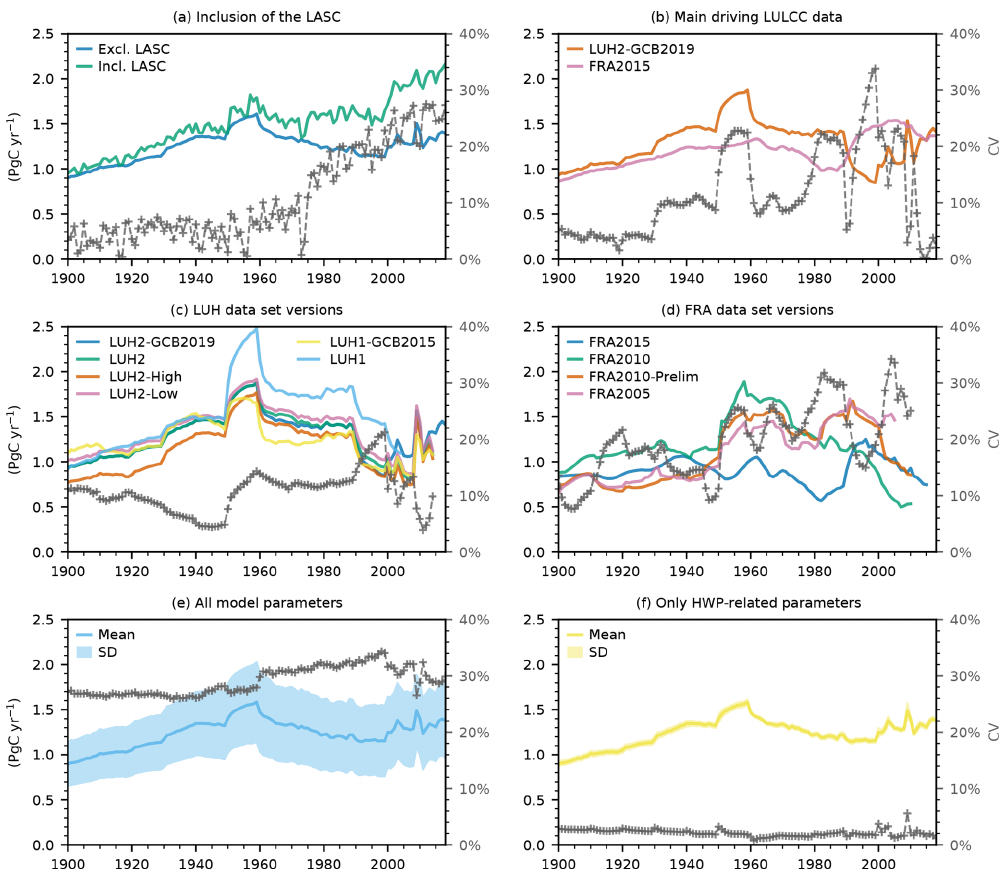
Figure 3. Variations and uncertainties in the time series of global annual LULCC emissions. (a) The effect of adding the LASC to LULCC emissions. (b) The effect of the LULCC driving data sets (only the two data sets used to estimate our best guess). (c) The effect of the data set version among the LUH variants (not used for our best guess). (d) The effect of the data set version among FRA variants. These emissions were not simulated by OSCAR; they were reported by Houghton and Nassikas (2017; their Fig. 8). (e) The effect of all of the parameters of OSCAR (using the weighted Monte Carlo ensemble). (f) The effect of the subset of parameters of OSCAR that are related to harvested wood products (i.e., the parameters that are not derived from DGVMs). All panels show bookkeeping LULCC emissions with the obvious exception of panel (a) . Thick colored lines show the values obtained by averaging over all axes of analysis apart from the one investigated in the panel. The dashed gray lines with markers show the debiased coefficients of variation (CVs), i.e., the ratios of the debiased standard deviation over the average, and refer to the y axis on the right-hand side of each